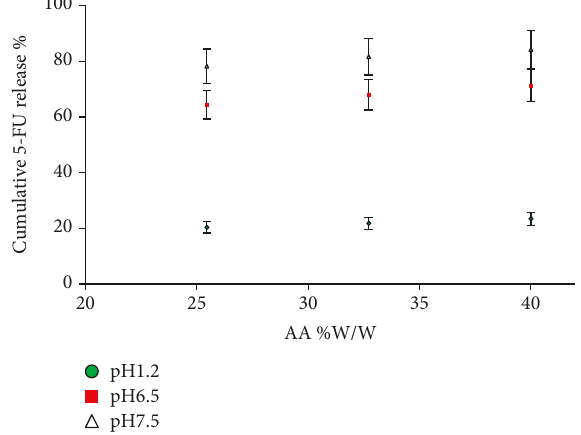
Figure 3: In vitro release of 5-FU from Poly (CMCS- g -AA) hydrogels using variable contents of AA (25.45, 32.72, and 40 g) and EGDMA as crosslinking agent (0.7% of AA) at various pH values and 37 ° C in 0.05 M USP phosphate bu ff er solutions.